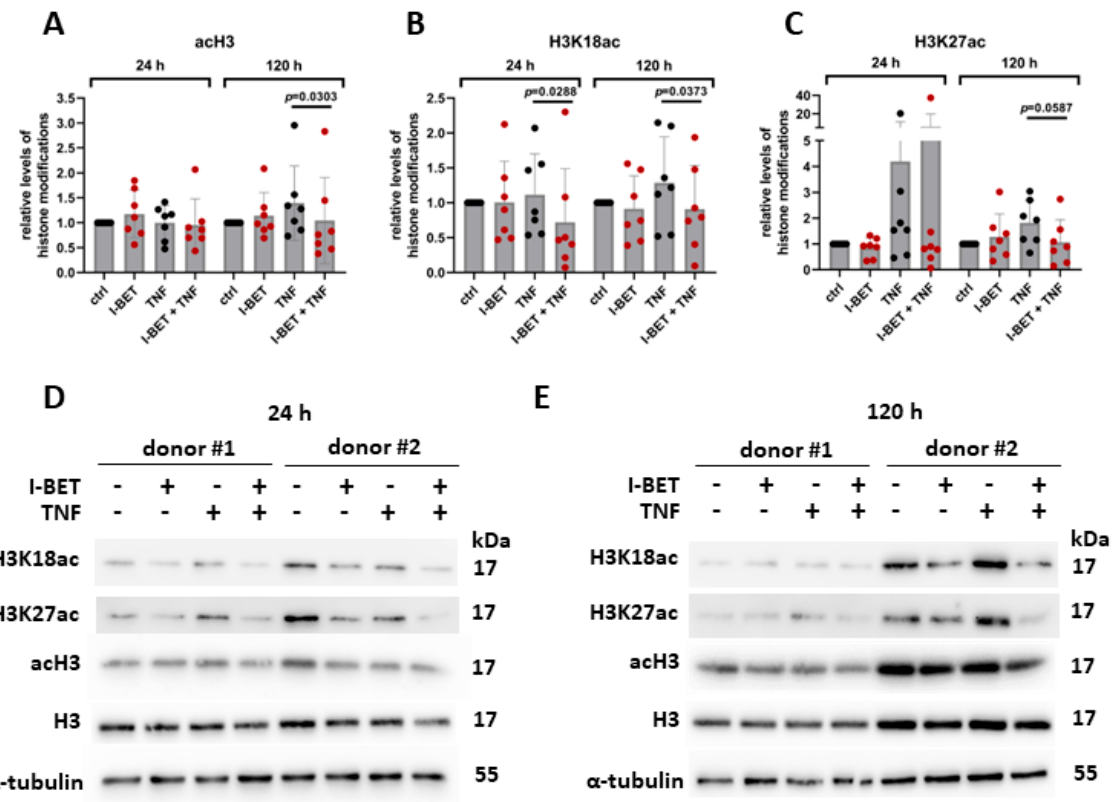
Figure 3. I-BET151-induced changes on TNF-induced histone acetylation in FLSs. FLSs were treated with I-BET151 and TNF for 24 h, following the scheme shown in Figure 1C (24 h). Alternatively, FLSs were pretreated with I-BET151, following the scheme shown in Figure 1B (120 h), followed by a TNF stimulation 24 h prior to harvesting. Densitometric analysis of Western blots ( n = 7) for ( A ) acetylated histone 3 (acH3), ( B ) H3 lysine 18 acetylation (H3K18ac), ( C ) H3 lysine 27 acetylation (H3K27ac). Changes in histone modi fi cations were quanti fi ed relative to the expression of α -tubulin. ( D ) and ( E ) represent Western blots of results shown in ( A – C ). Original membranes are shown in Supplementary Materials.